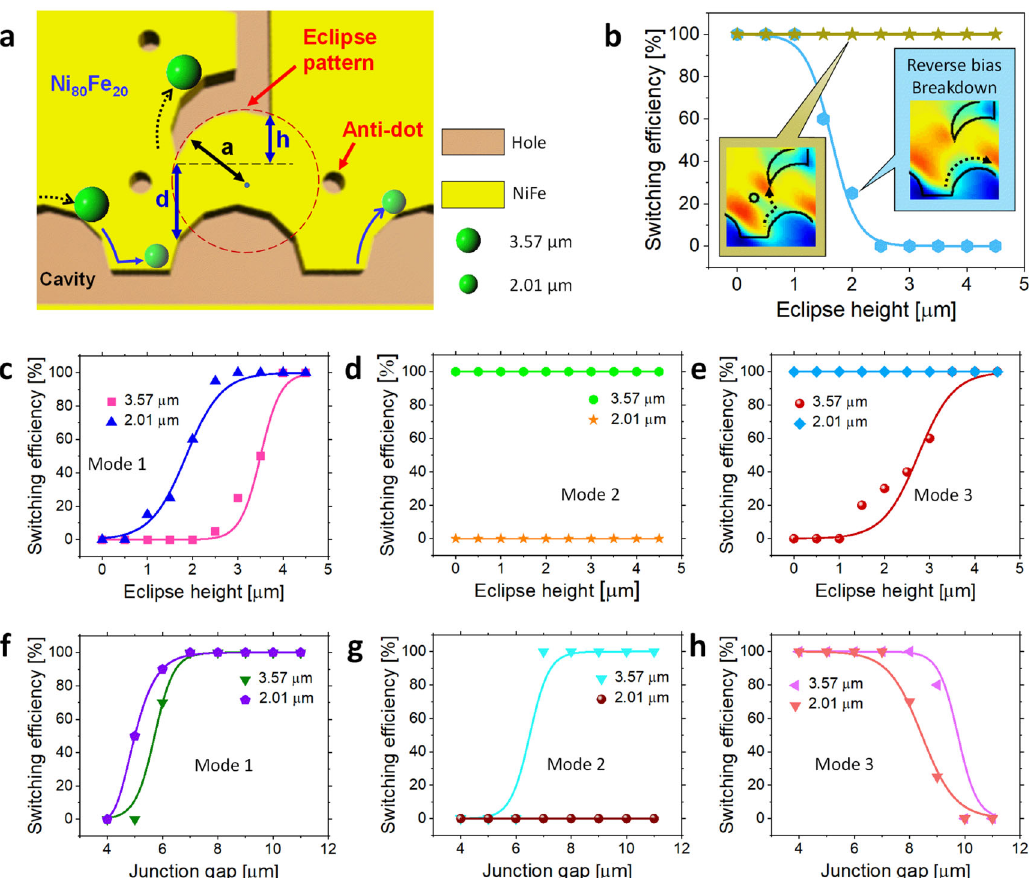
Fig. 6 Switching ef fi ciency of PsD holes on eclipse diode patterns. a Schematic diagram representing the geometrical construction of the eclipse diode with an anti-dot 2 µ m in diameter. Here, “ a ” is the radius (5 µ m) of the disk pattern, “ d ” is the junction gap (7 µ m), and “ h ” is the eclipse height (4 µ m). b Switching ef fi ciency comparison for 3.57 µ m PsD holes with and without an anti-dot. The diode integrated with an anti-dot acquires 100% switching ef fi ciency at all eclipse heights, whereas the absence of an ant-dot leads to zero switching ef fi ciency above 2 µ m eclipse height. c – e Switching ef fi ciency of 2.01 and 3.57 µ m PsD holes at various eclipse heights ( h ) on an eclipse diode with an anti-dot pattern. f − h Switching ef fi ciency of 2.01 and 3.57 µ m PsD holes at various junction gaps ( d ) on an eclipse diode with an anti-dot